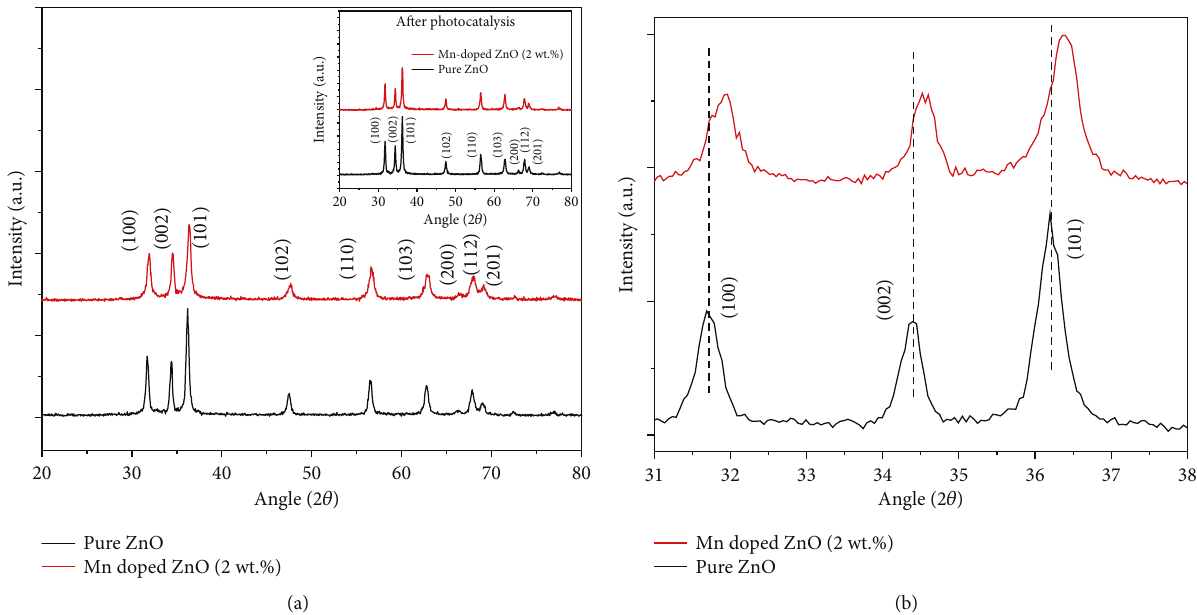
Figure 3: (a) The XRD patterns of pure and Mn-doped (2 wt. %) ZnO nanoparticles before and (inset) after photocatalysis and (b) the relative peak shift towards higher angles with Mn-doping in the ZnO host